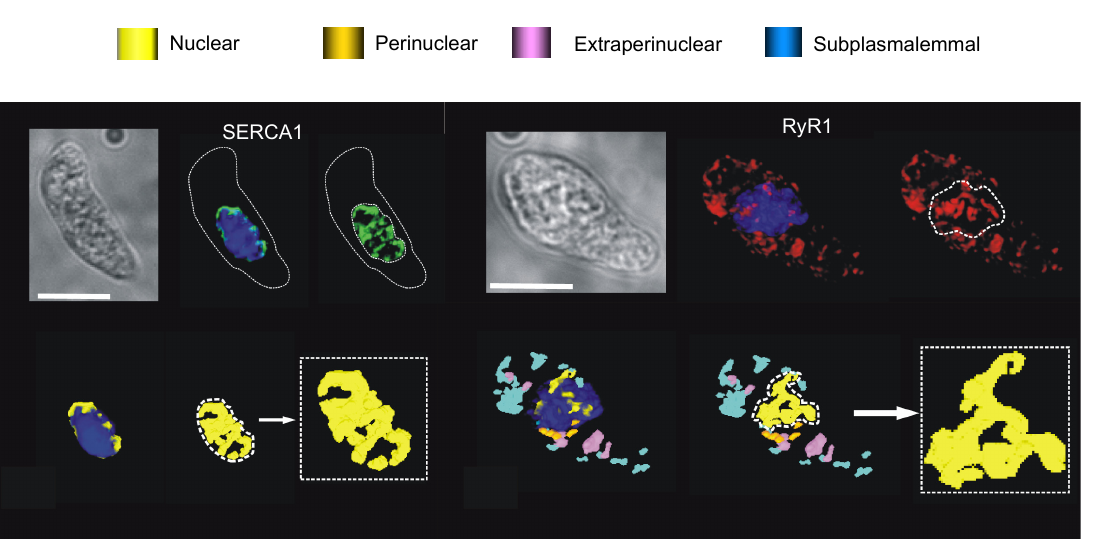
Figure 10. Example cells showing labelling for SERCA1 ( left hand panels) and RyR1 ( right hand panels) in pulmonary arterial myocytes. In each case, upper panels show, from left to right, a bright field image, and 3D reconstructions with and without DAPI labelling (navy blue = nucleus). Lower panels show 3D digital representation of labelling colour coded by region of the cell. Scale bars, 10 μ m.